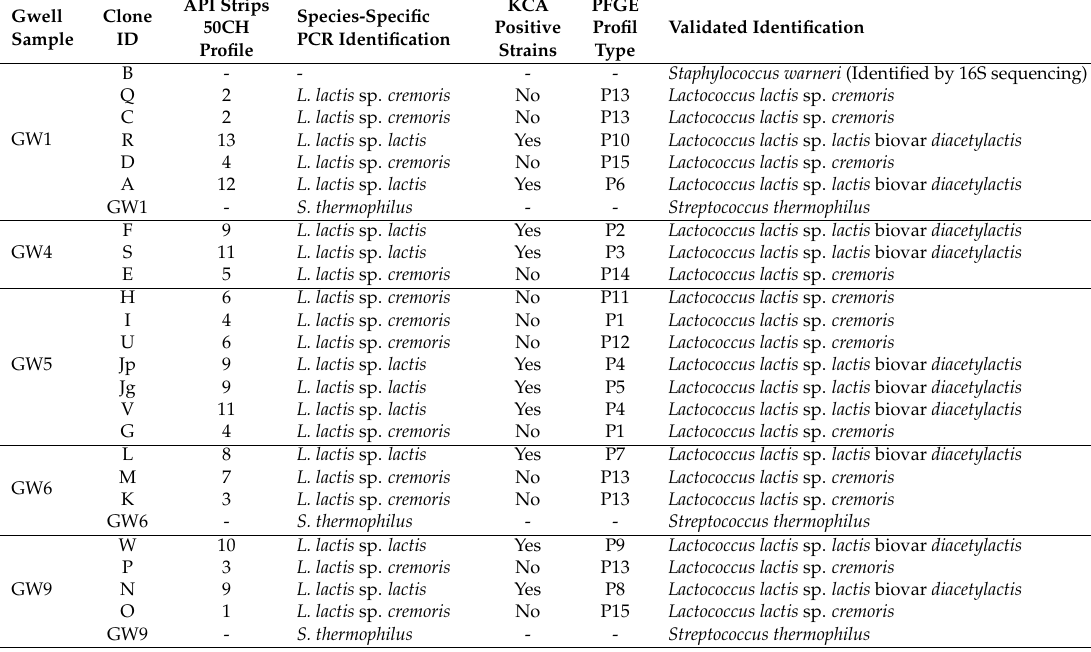
Table 3. Identification results obtained for the 26 strains isolated from the typical Gwell